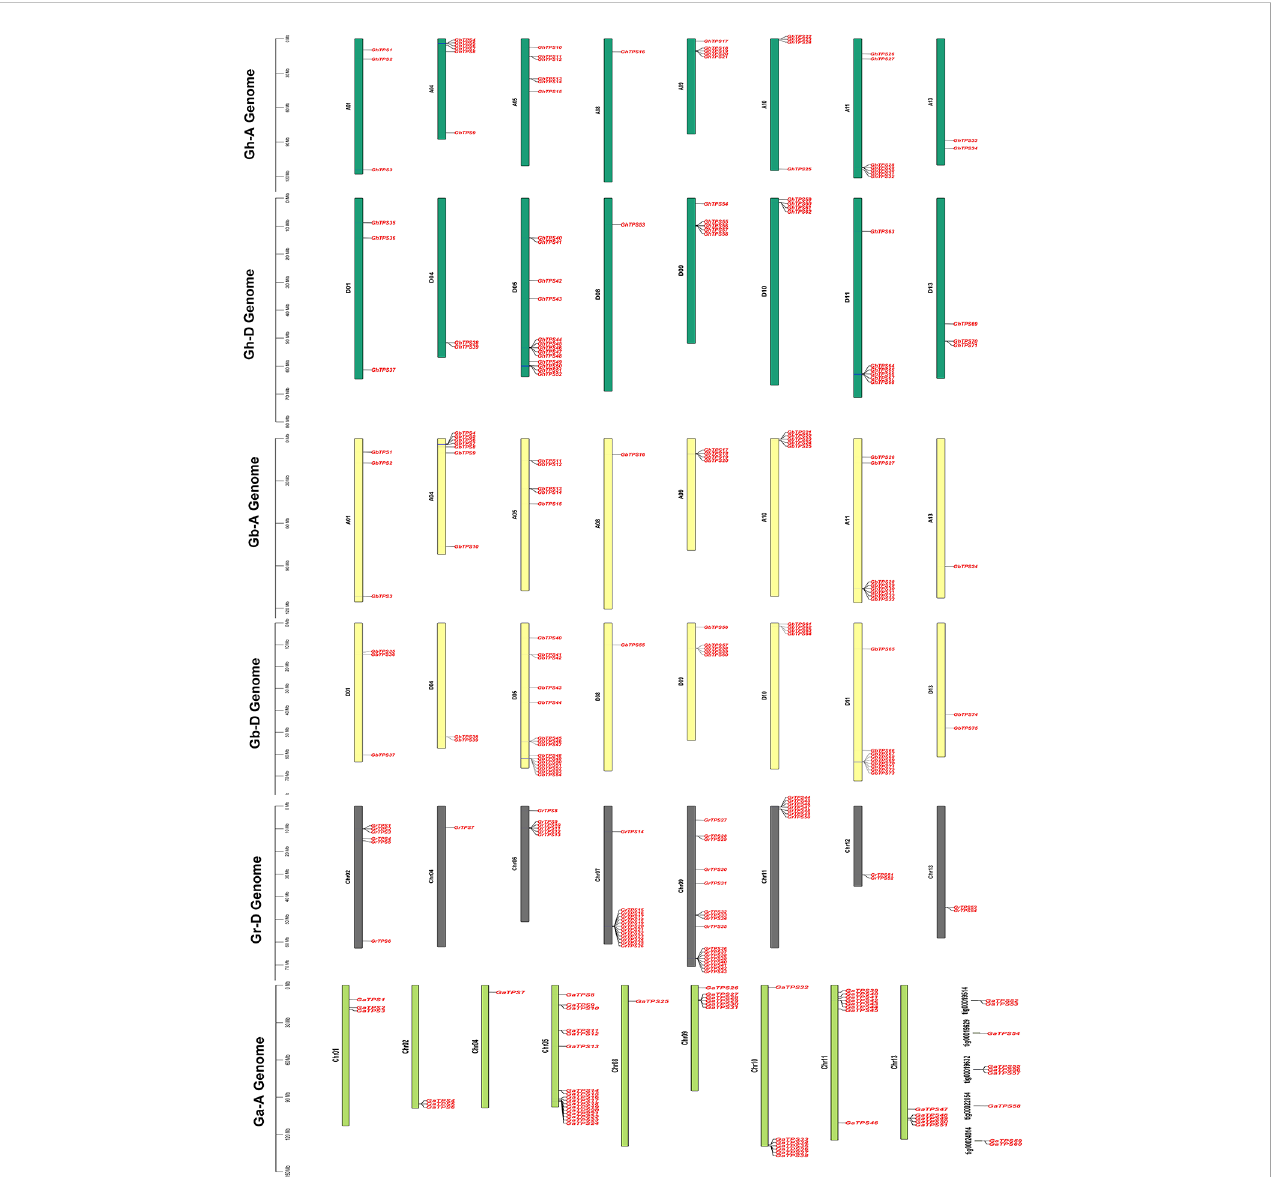
FIGURE 2 Chromosomal mapping of TPS in Gossypium. The vertical bars indicate the physical location of genes and the length of chromosomes. The gene names are on the right side of chromosomes. The four colors represent the four cotton